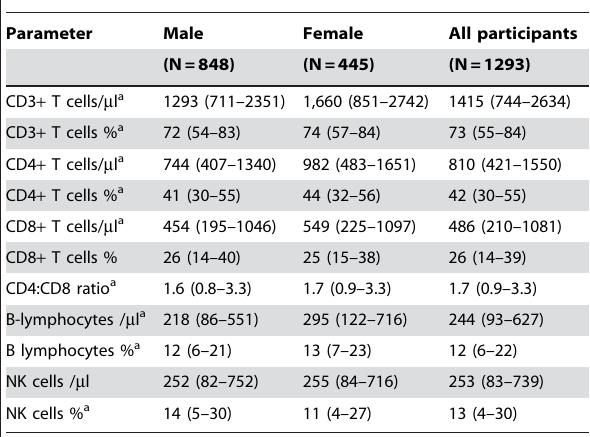
Table 1. Lymphocyte subset reference ranges (median and